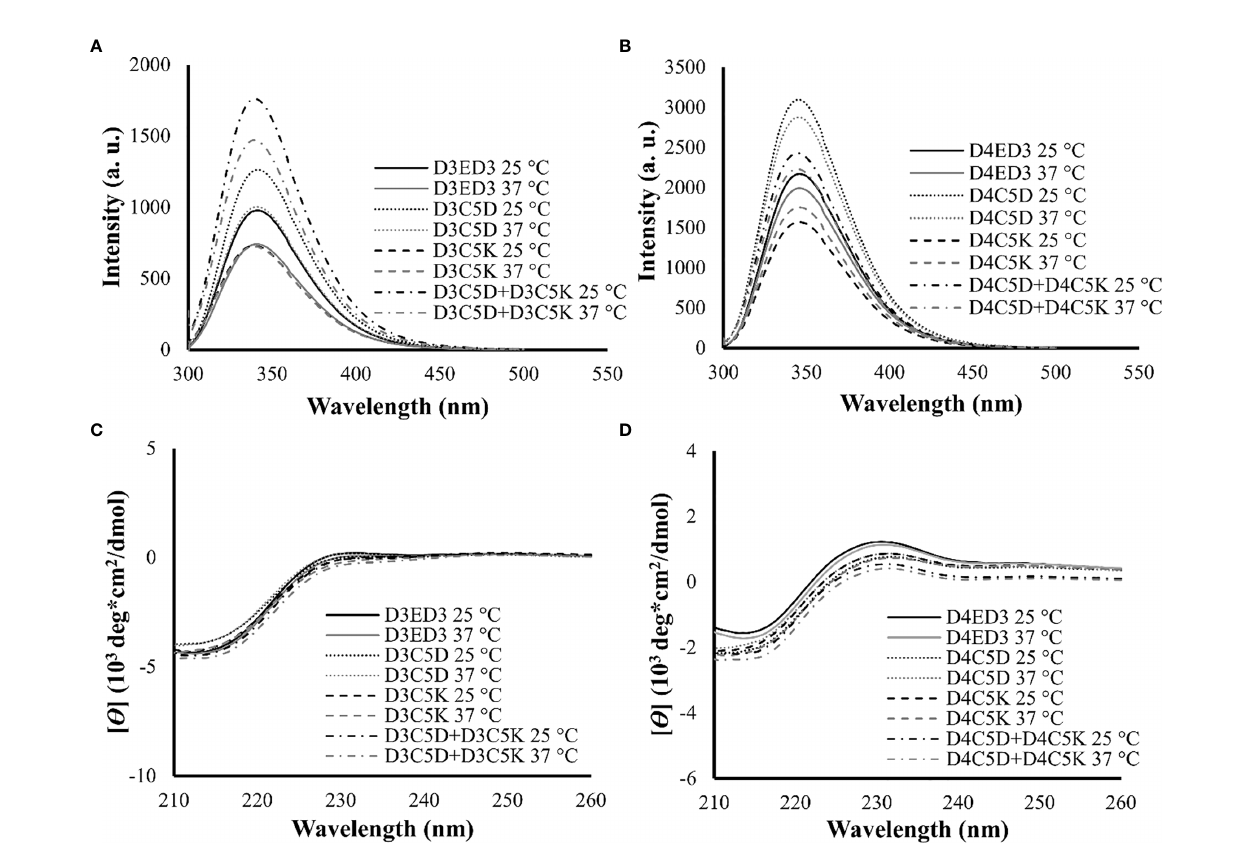
FIGURE 3 | Structural characterization of SCP-tag induced sub-visible aggregates of homotypic ED3s by fl uorescence and CD measurements. Trp- fl uorescence spectra of (A) D3ED3 and (B) D4ED3 vatiants and CD spectra of (C) D3ED3 and (D) D4ED3 vatiants measured at 25° and 37°C. All protein samples were formulated at a fi nal concentration of 0.3 mg/mL in PBS, pH 7.4 except D3C5D+D3C5K and D4C5D+D4C5K, which were formulated in phosphate buffer (PB, pH 7.0). Three accumulations were taken for each measurement. Line symbols are explained within the